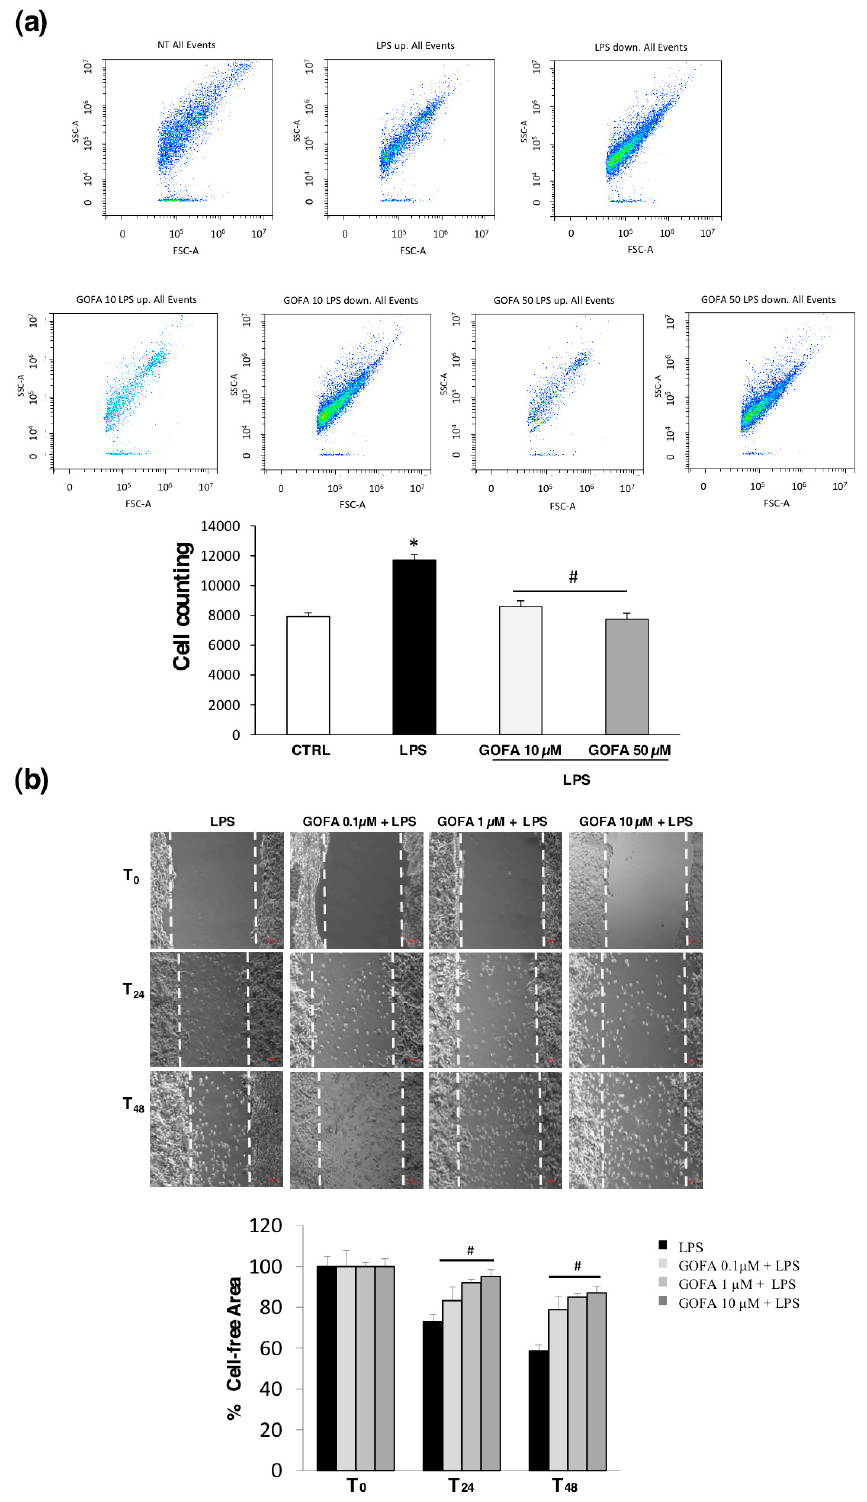
Figure 4. Determination of GOFA effect on U937 and HCT116 cell migration. ( a ) Flow cytometric density dot plots (FSC / SSC) of U937 cells, show that cell populations are consistent in the bottom chamber when cultures are stimulated with LPS and treated with GOFA (10 and 50 µ M) for 24 h (upper